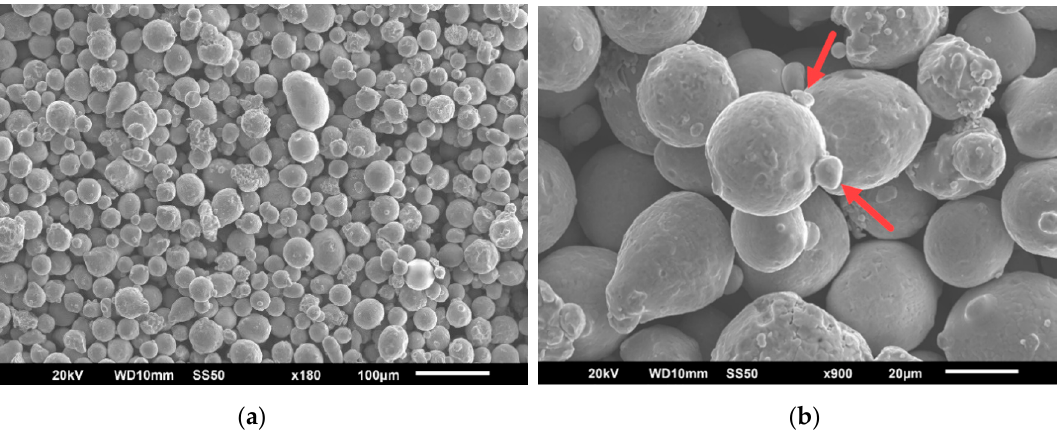
Figure 1. Scanning electron microscopy (SEM) image of 316L metallic powder, magnification x180 ( a ); satellites with red arrows, magnification x900 ( b ).